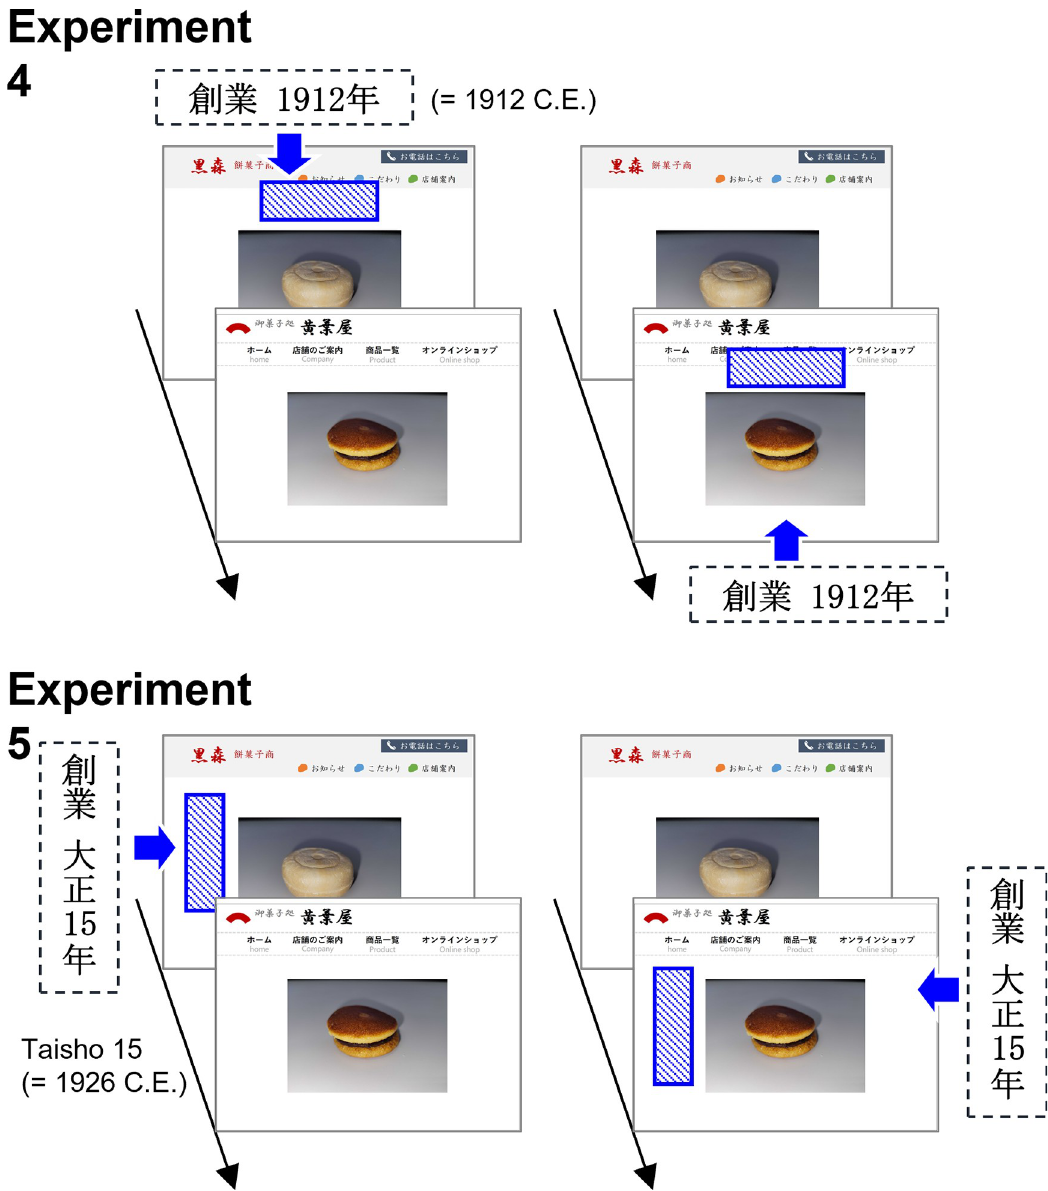
Fig 8. Schematic of a trial sequence from Experiments 4 and 5. The restaurant’s year of establishment was displayed on the label as 1912 C.E. using the Gregorian calendar in Experiment 4, and as 1926 C.E. using the Taisho era date format in Experiment 5. The label-present and -absent conditions were counterbalanced across